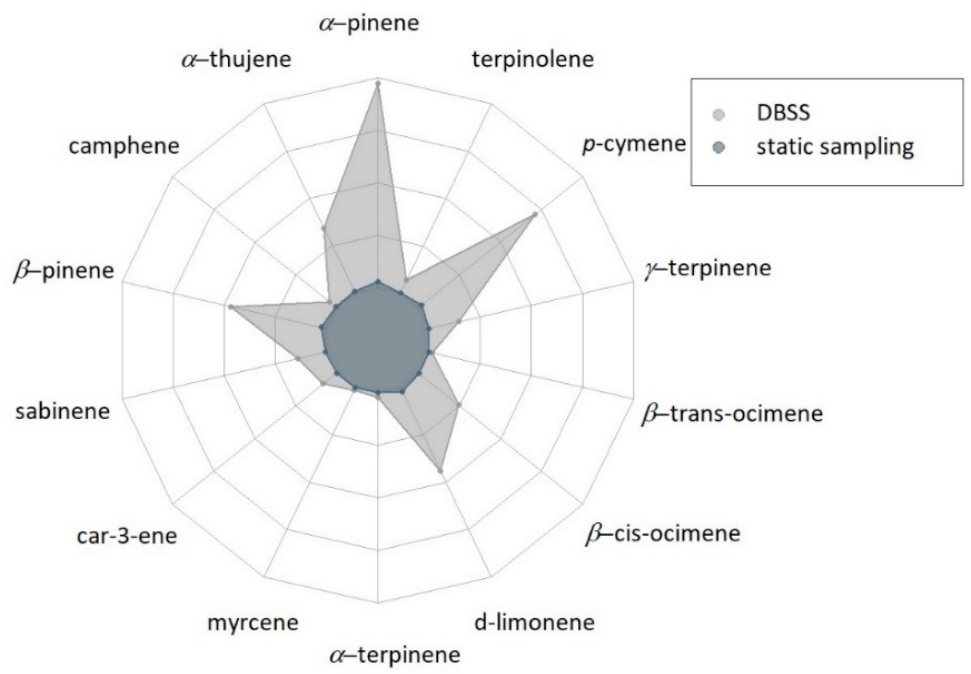
Figure 3. Radar-plot showing the results of the semi-quantitative analysis of BVOCs at sampling point 3 ( n = 3) expressed as the peak area of each individual compound. The amounts of different compounds range between 0 and 1,350,000. Results of statistical analysis are reported in Table S3.